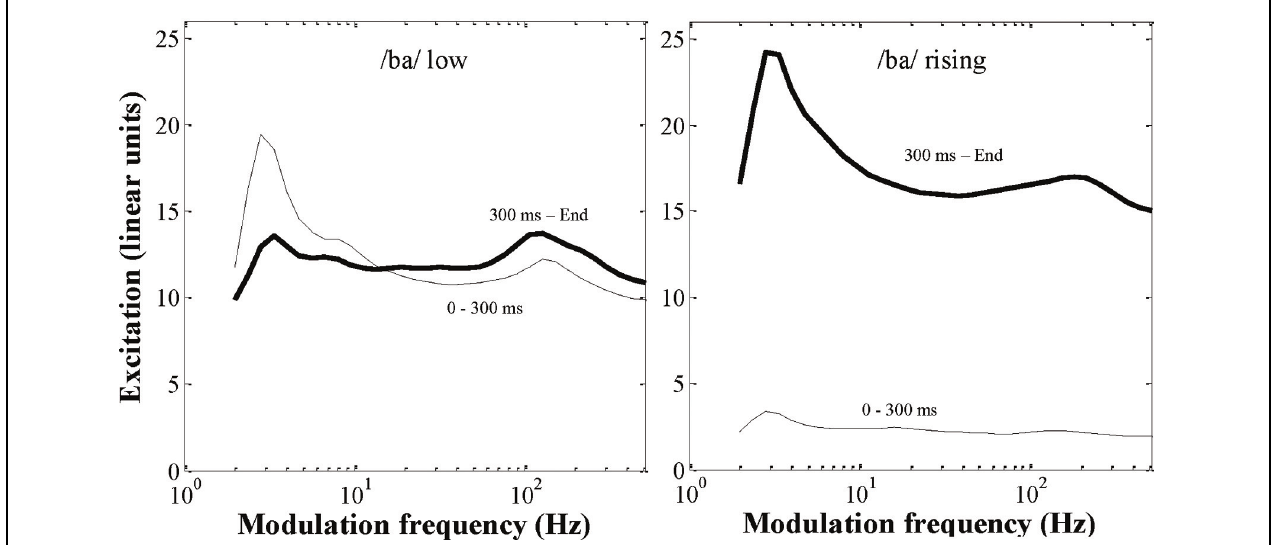
FIGURE 3 | Modulation excitation patterns computed for /ba/ low (left) and /ba/ rising (right) stimuli in the Vocoded condition. Modulation excitation patterns show modulation power (in linear units) as a function of the center modulation frequency of modulation filters (ranging between 2 and 512 Hz). Modulation excitation patterns were computed for the highest (i.e., the eighth) analysis channel only